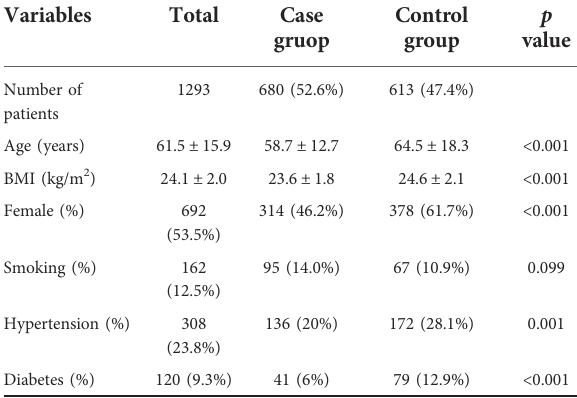
TABLE 1 Baseline characteristics of 1,293 patients in the case group and control group.